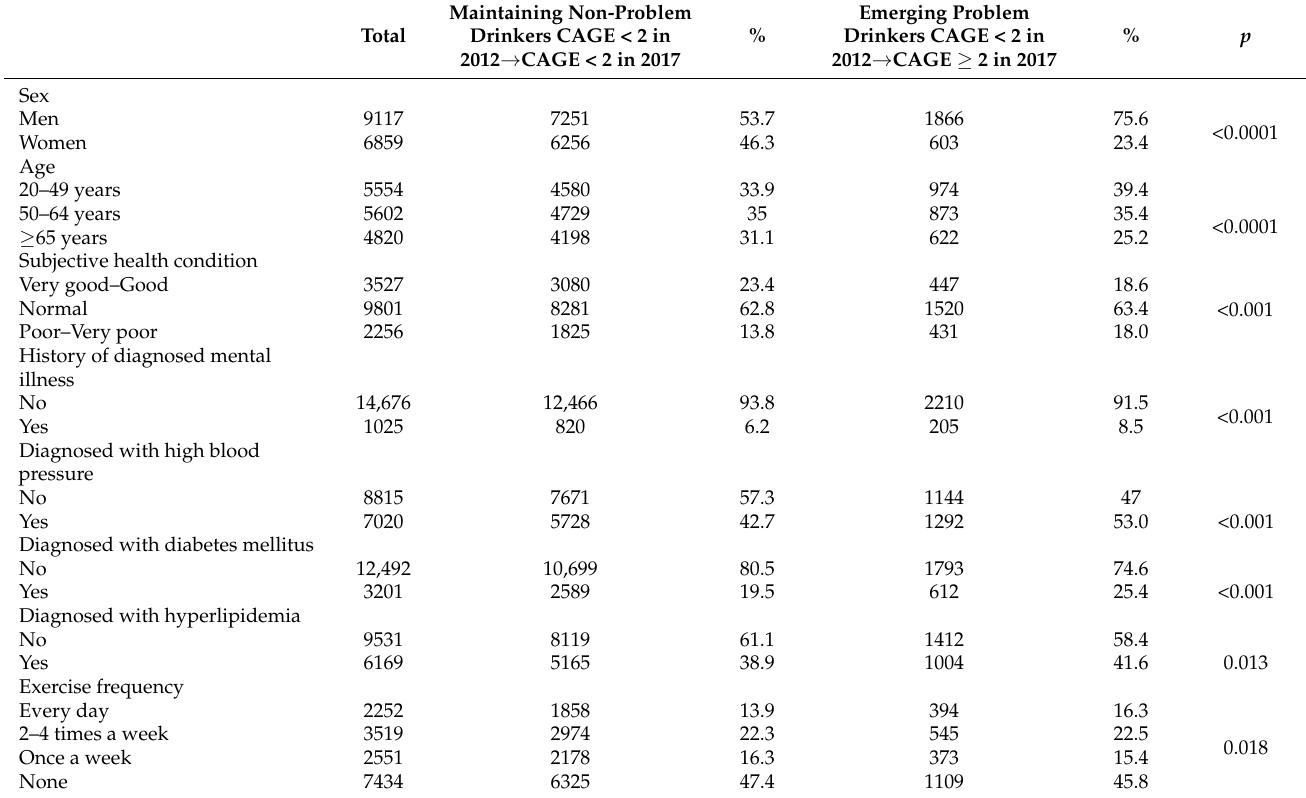
Table 1. Characteristics of participants who only developed problem drinking after FY